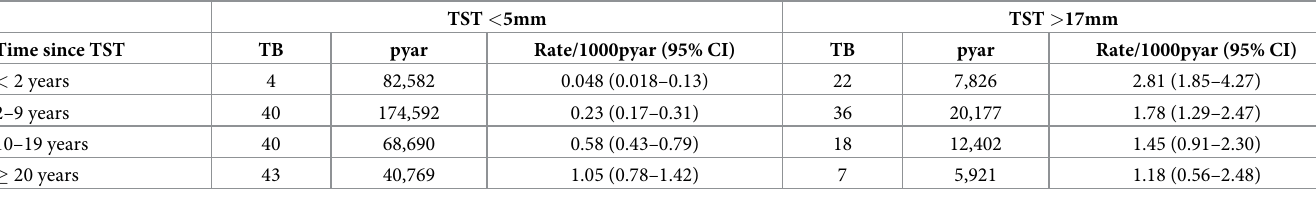
pyar = person years at risk, CI = confidence